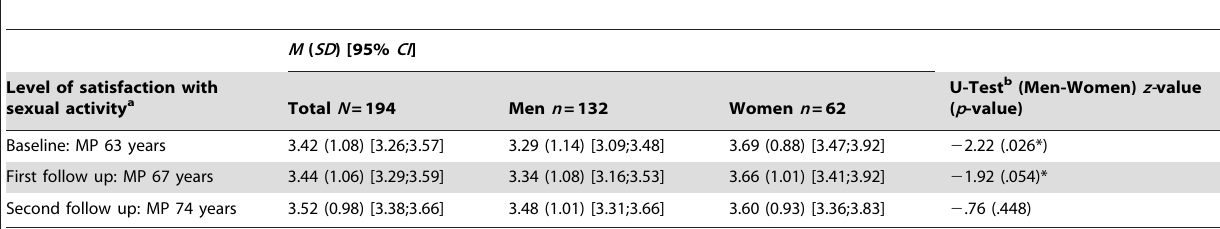
Table 2. Levels of satisfaction with sexual activity at MP 62, 66 and 74 years: total sample by